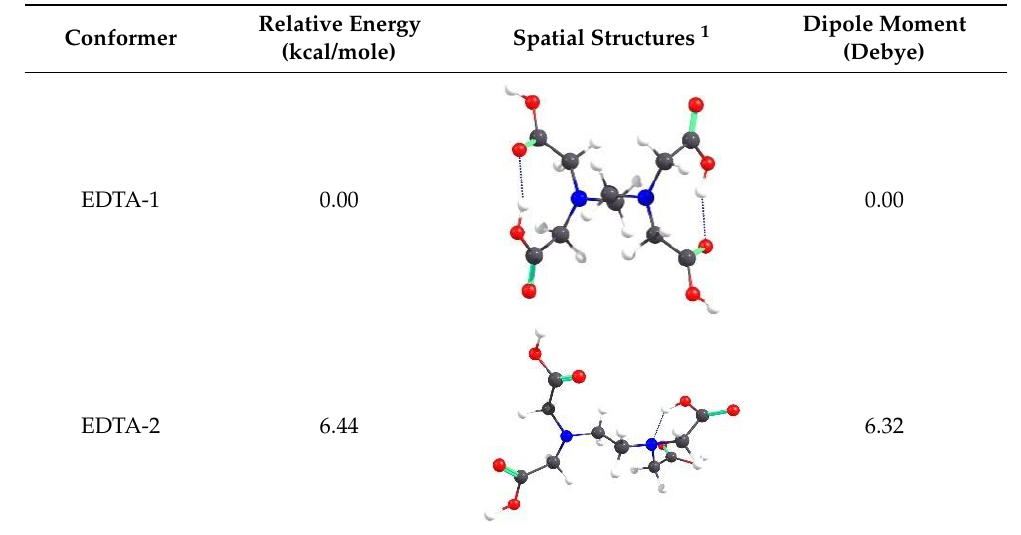
Table 4. Conformers of EDTA.